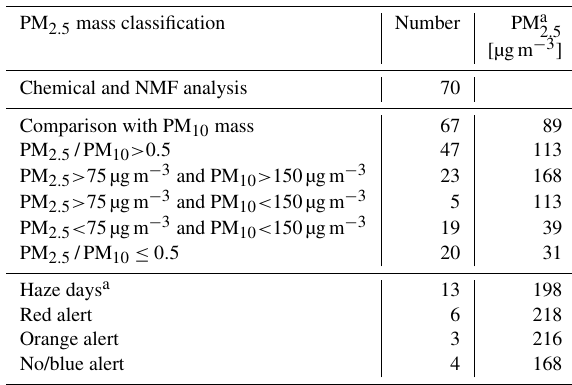
Table 1. Statistics of PM 2 . 5 mass